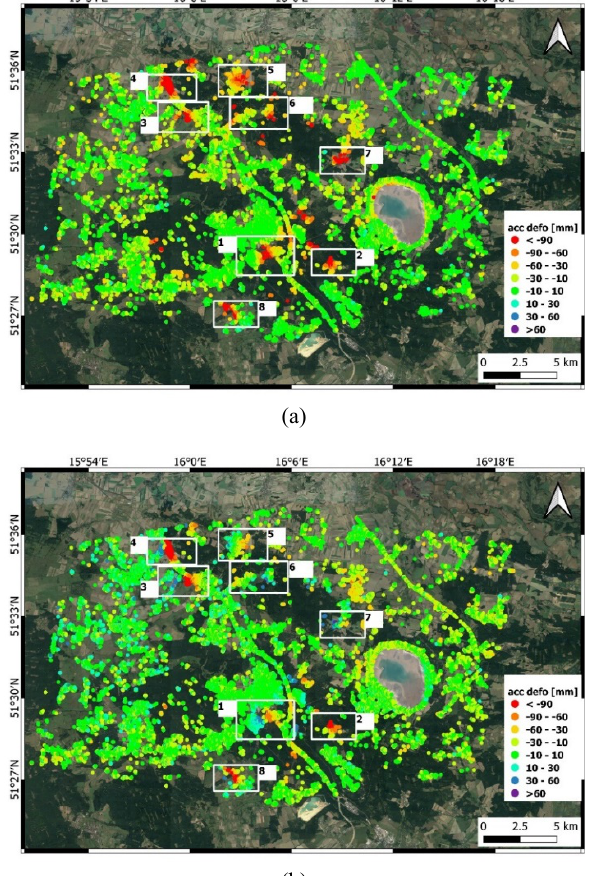
Figure 4 . Up-Down (a) and East-West (b) accumulated deformation maps of the area of